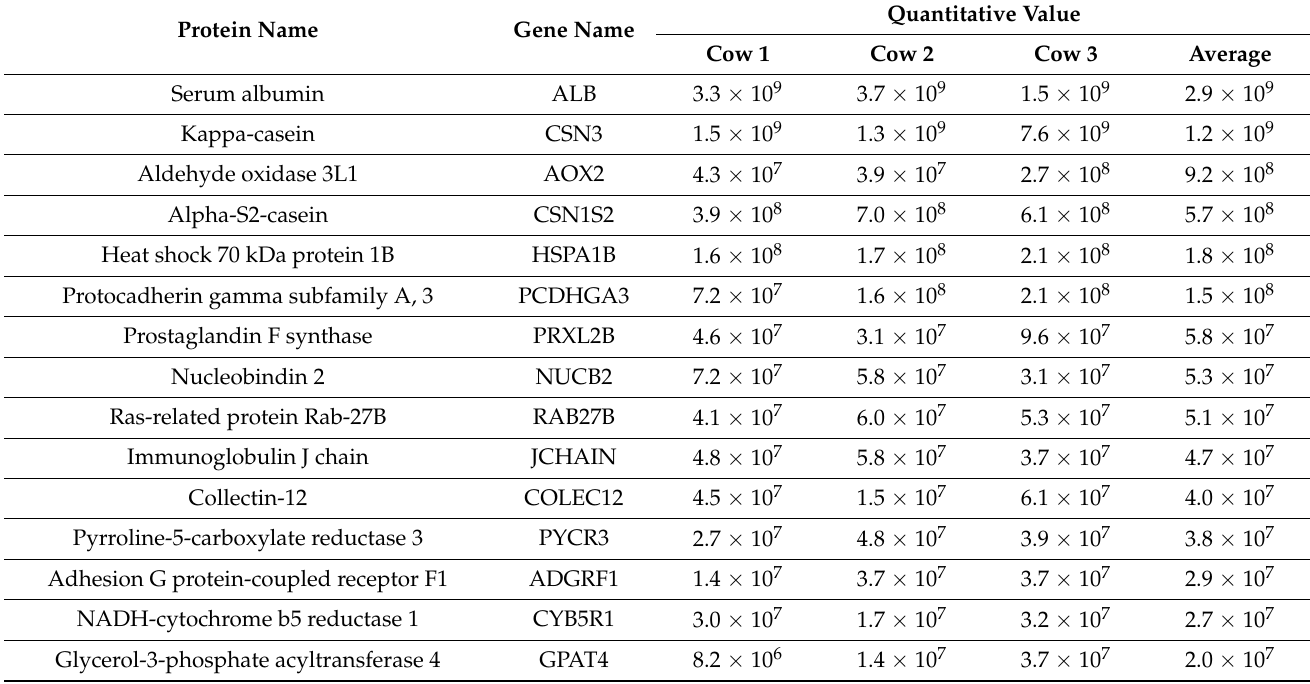
Table 2. Top 50 newly identified proteins in milk sEVs from late-stage lactating cows.